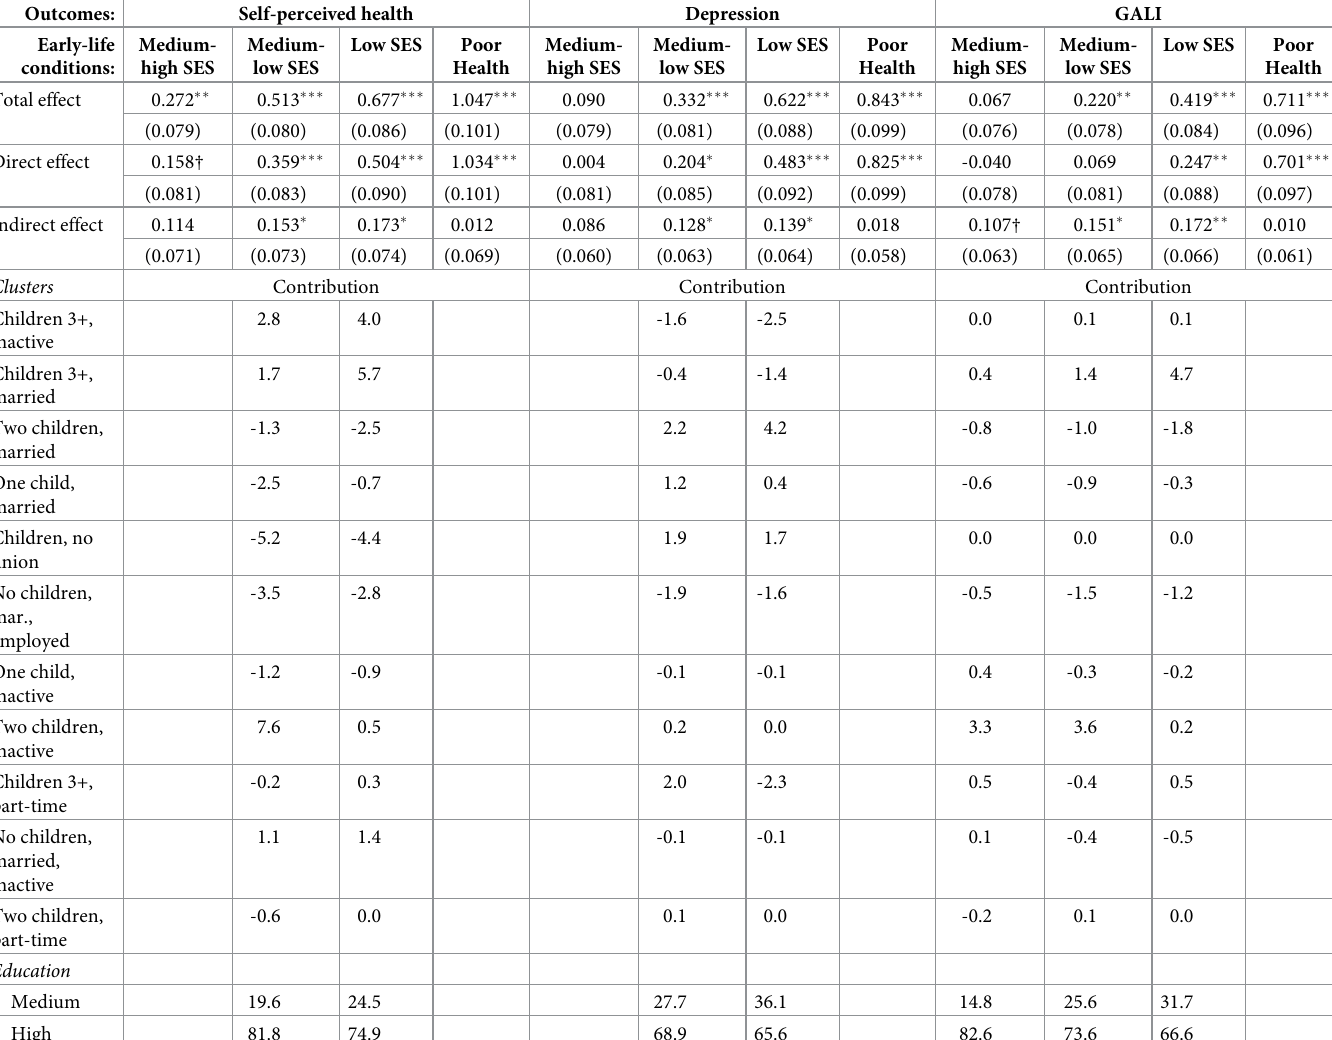
Table 1. Estimated linear and logistic regression coefficients (standard errors in parentheses of SES and Health at 10 (early-life conditions) on three measures of health and mediating effect of life course trajectories and education. Women. (N = 6,221).